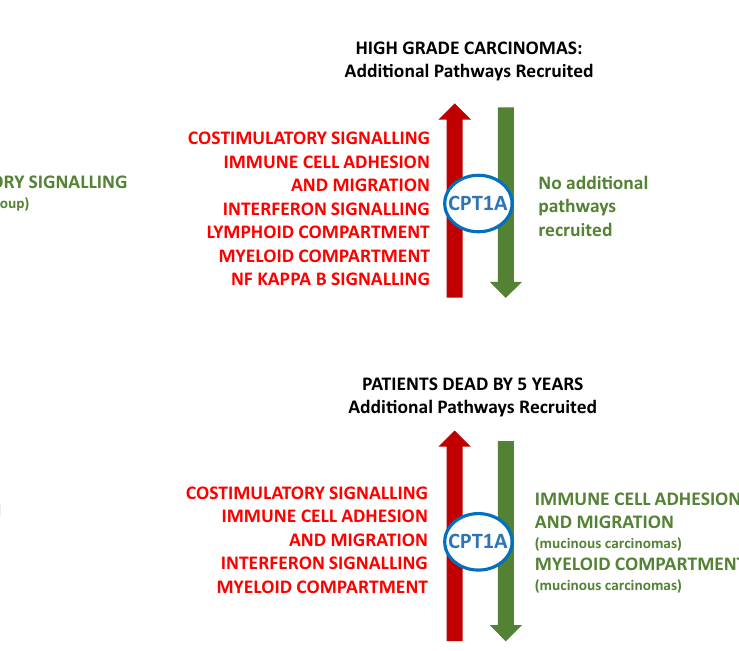
Figure 4. CPT1A clustering with immune pathways. Visual depiction of the clustering of CPT-1A with signalling pathways and whether the clustering occurs in the context of overexpression (red colour, left) or underexpression (green colour, right). The top left image shows the pathways which cluster with CPT-1A in the primary breast carcinomas. The remaining images show the additional pathways which cluster with CPT-1A in high grade carcinomas (top right), advanced stage or recurrence (bottom left) and in patients with a worse prognosis, as indicated by death by 5 years (bottom right). Where clustering is limited to a particular subgroup of carcinomas (receptor status or histological subtype), this is indicated in brackets beneath the signalling